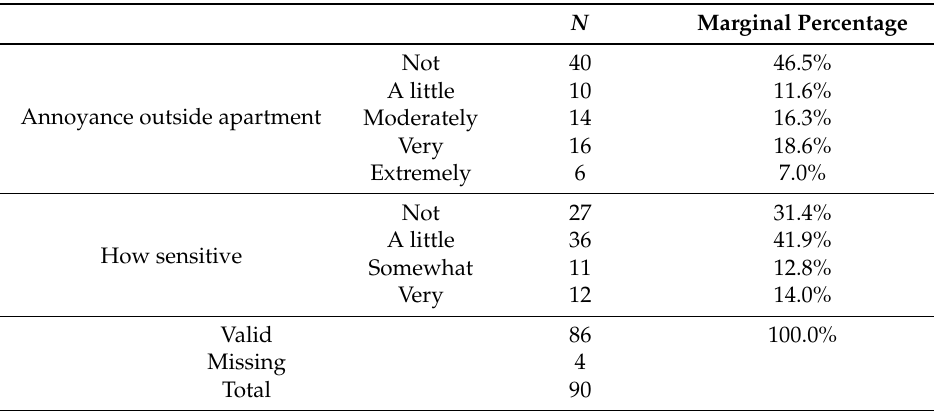
Table A2b. Case processing